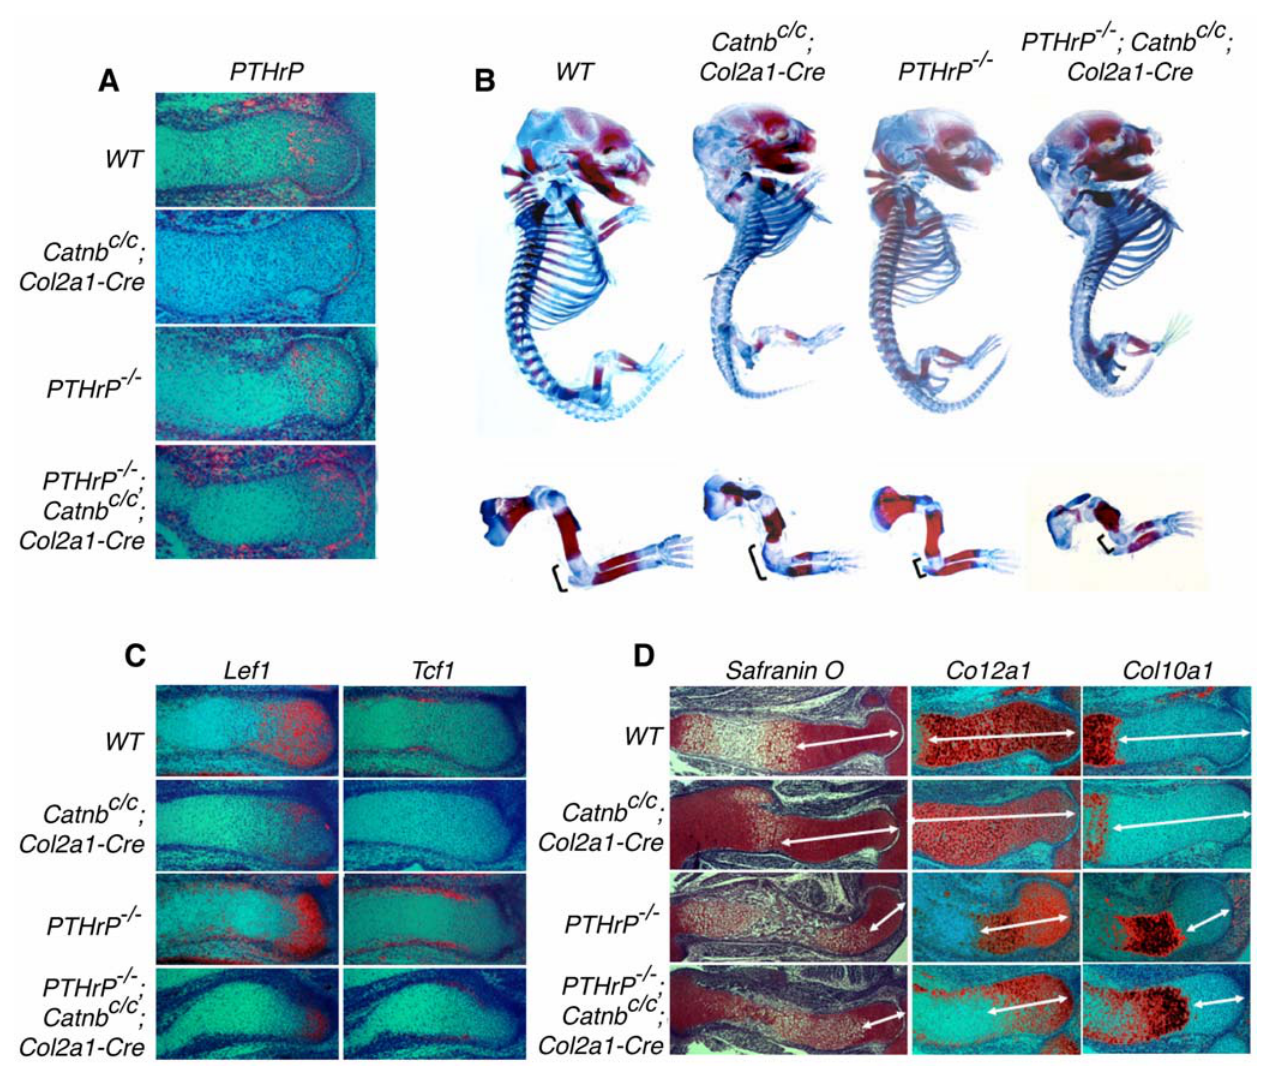
Figure 1. Analysis of PTHrP and b -catenin mutant skeletons. (A) Sections of developing humerus at 14.5 dpc were examined by in situ hybridization with PTHrP probes. Expression of PTHrP was reduced in periarticular chondrocytes in Catnb c/c ; Col2a1-Cre single mutant embryos compared to that in wild type embryos. PTHrP expression was increased in the double mutant embryos compared to that in the Catnb c/c ; Col2a1-Cre single mutant embryos. (B) Skeletal preparation of 16.5 dpc embryos. A forelimb of each embryo is shown in lower panel. Alizarin red stains the mineralized hypertrophic chondrocytes and bone. Alcian blue stains the unmineralized cartilage. Mineralization was accelerated in the PTHrP 2 / 2 ; Catnb c/c ; Col2a1-Cre double mutant and the PTHrP 2 / 2 single mutant. The bracket indicates the non-mineralized cartilage at the joint region. (C) Consecutive sections of the radius at 14.5 dpc were examined by in situ hybridization with probes of Lef1 and Tcf1 . Lef1 and Tcf1 expression were downregulated in both Catnb c/c ; Col2a1-Cre single mutant and PTHrP 2 / 2 ; Catnb c/c ; Col2a1-Cre double mutant embryos. (D) Consecutive sections of the developing humerus at 14.5 dpc were examined by Safranin O staining and in situ hybridization with the indicated riboprobes. Safranin O staining and expression of Col2a1 marked nonhypertrophic chondrocytes. The nonhypertrophic domain (double headed arrow) was expanded in Catnb c/c ; Col2a1-Cre mutant embryos whereas it was shortened to the same degree in PTHrP 2 / 2 single mutant and PTHrP 2 / 2 ; Catnb c/c ; Col2a1-Cre double mutant embryos. Col10a1 expression marked hypertrophic region, which was accelerated to the same level in PTHrP 2 / 2 single mutant and PTHrP 2 / 2 ; Catnb c/c ; Col2a1-Cre double mutant embryos.